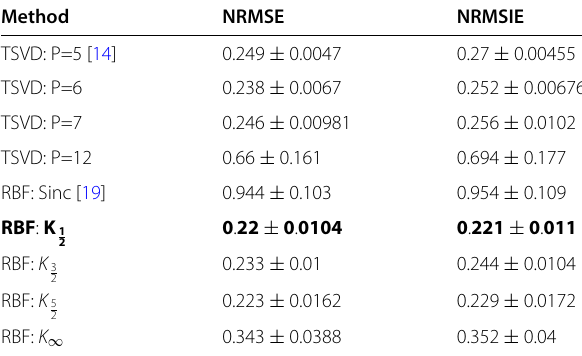
Table 1 Fourfold cross-validation errors for far-field speaker responses (mean, variance, 10